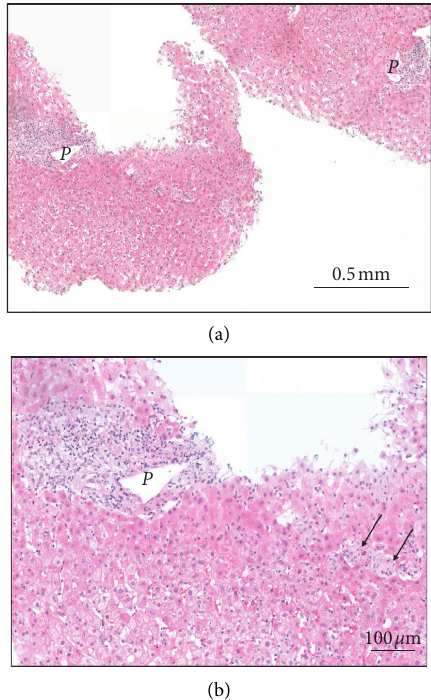
Figure 2: Histological view of the liver biopsy specimen (hematoxylin-eosin stain) showing normal architecture and no fibrosis (original magnification × 100, panel A). At a closer view (panel B, original magnification × 200), an inflammatory infiltrate is present in the portal tract P, predominantly lymphocytic, associated with scattered eosinophils. In the liver lobule, few necrotic hepatocytes and occasional microgranulomas (arrows) are visible. Periodic acid Schiff (PAS) and Ziehl staining are negative for